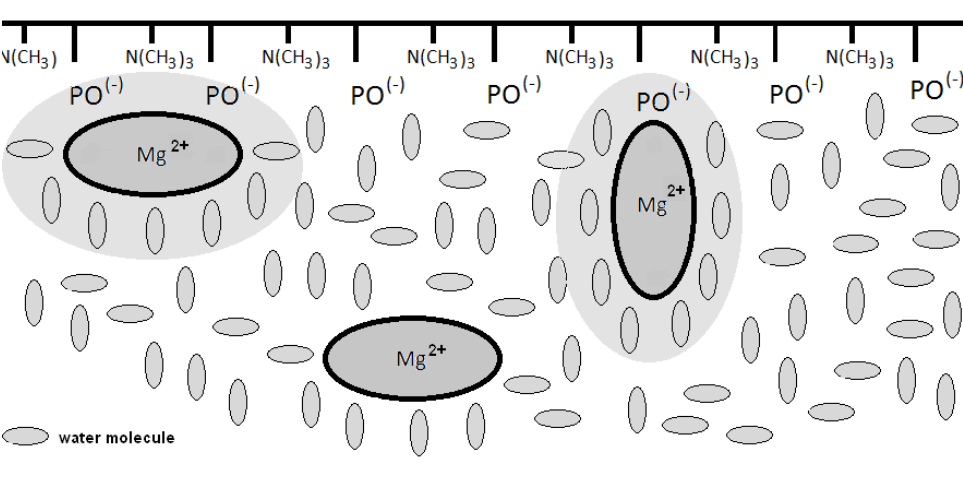
Mg complex formation). 2